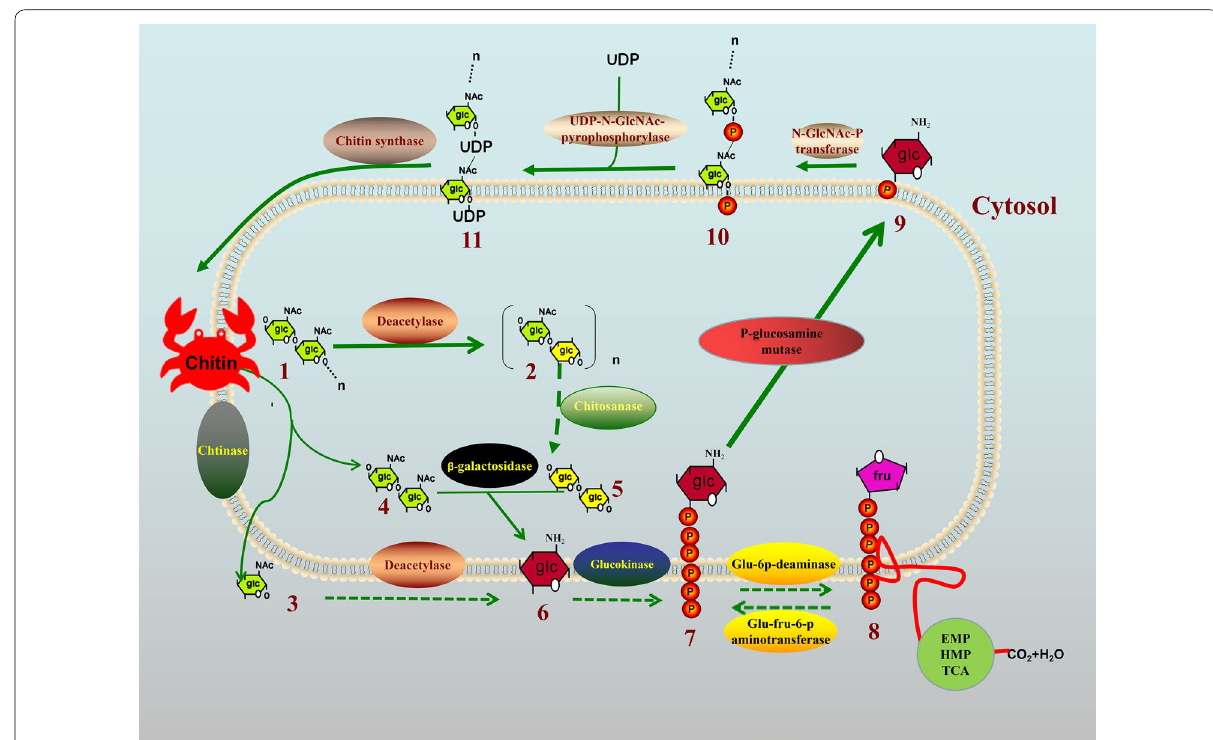
Fig. 4 Proposed chitin degradation and synthesis pathways of CS1801. 1: Chitin; 2: chitosan; 3: GlcNAc; 4: (GlcNAc) 2 ; 5: (GlcN) 2 ; 6: GlcN; 7: 6-phosphate-GlcN; 8: 6-phosphate-fructose; 9: GlcN-1-phosphate; 10: N -GlcNAc-1-phosphate; 11: